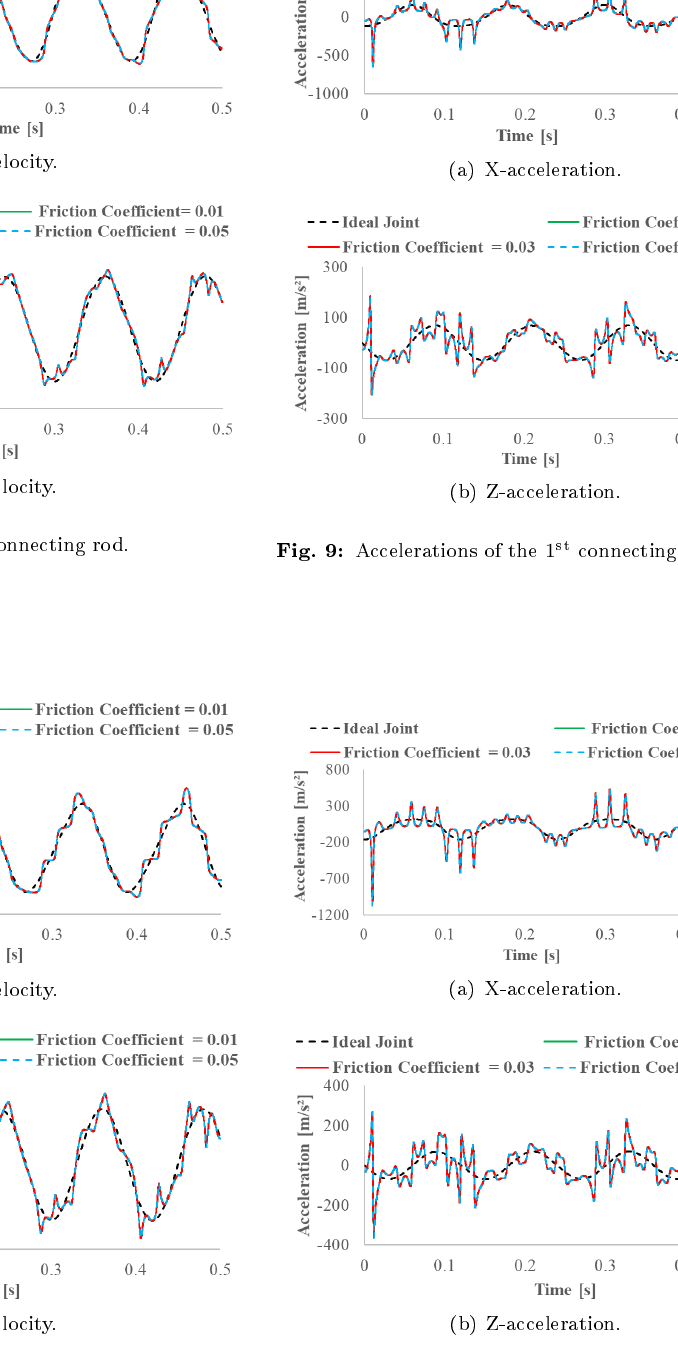
Fig. 8: Velocity of the 2 nd connecting rod.